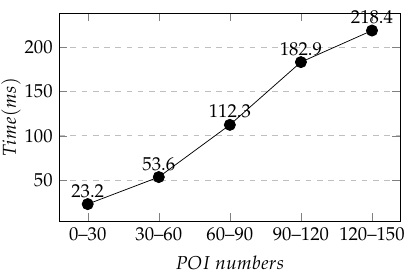
Figure 10. Number of POIs and calculation time of s 1 – s 5 under level 12.